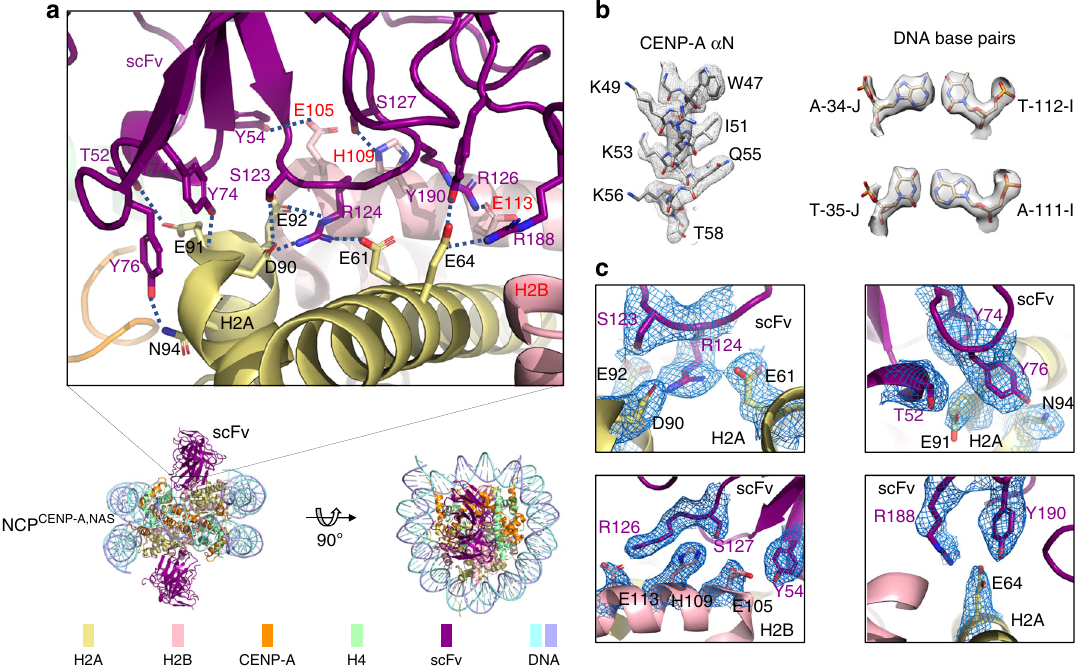
Fig. 2 Overall structure of the scFv-NCP CENP-A, NAS complex and interactions between scFv and NCP CENP-A, NAS . a The overall structure of the scFv- NCP CENP-A, NAS complex. Enlarged region shows the detailed interactions between scFv and the H2A – H2B dimer. Dashed lines show hydrogen bonds with distances less than 3.0 Å. Side chains are shown in sticks. Oxygen and nitrogen atoms are colored in red and blue, respectively. Residues in scFv, H2A, and H2B are labeled in magenta, black, and red, respectively. b Illustration of density maps for assignment of typical DNA base pairs, and a region in α N-helix of CENP-A. Maps were prepared in Chimera 47 . c Cryo-EM density maps of the scFv and H2A – H2B residues that form direct interactions as shown in ( a ), contoured at 3 σ . Both ( a ) and ( c ) were prepared using